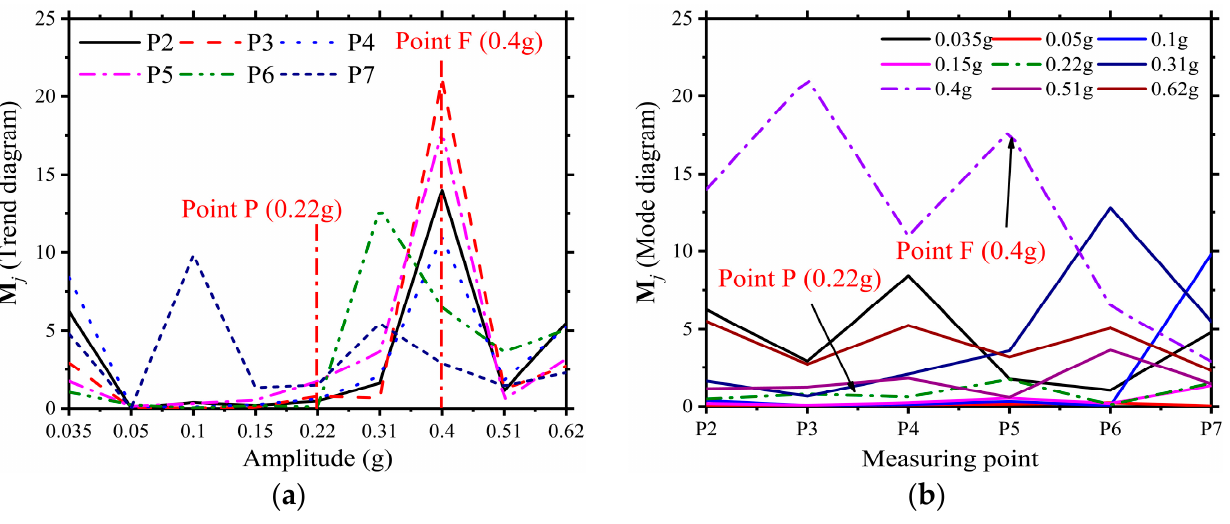
Figure 6. The mutation features of the stressing state mode M j . ( a ) M j (Trend diagram); ( b ) M j (Mode diagram).